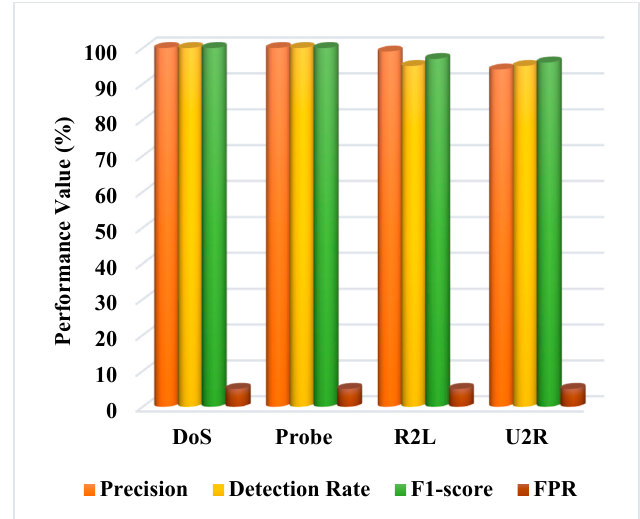
Figure 17. False detection rate.